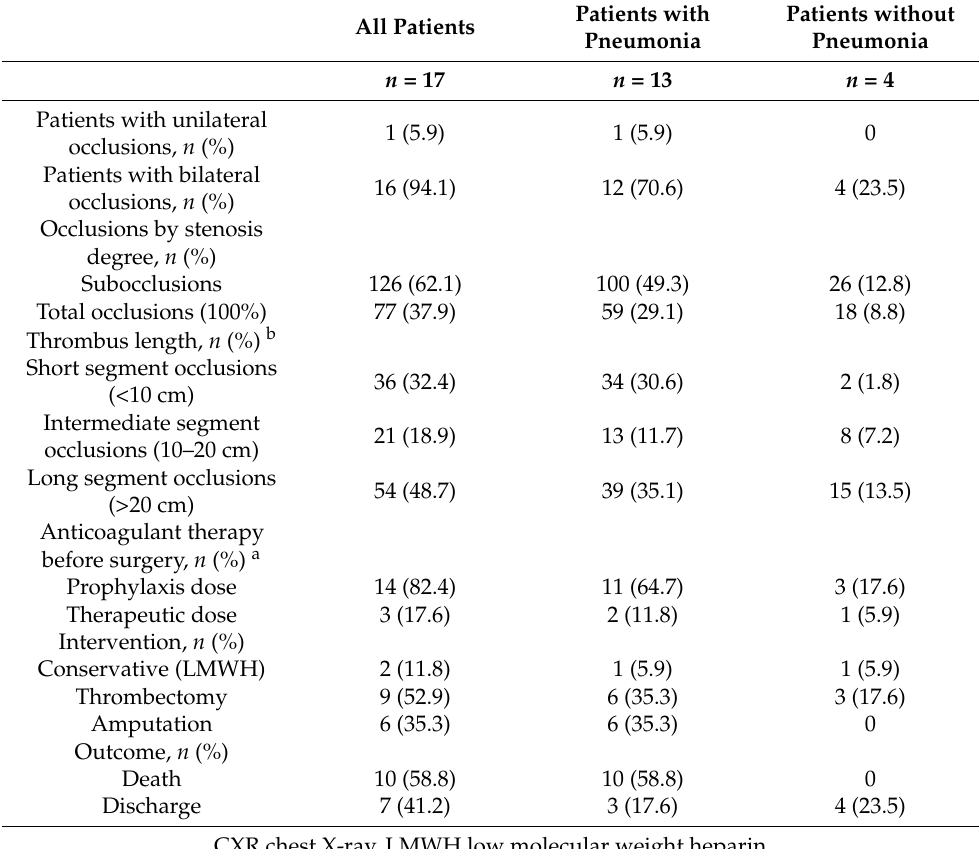
Table 3. CTA findings, intervention, and outcome data of the patients.